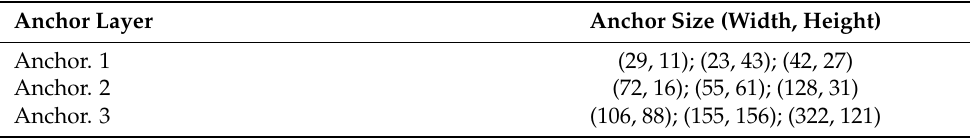
Table 8. The anchor mask setting parameters derived from Figure 7. Anchor Layer Anchor Size (Width, Height) Anchor.